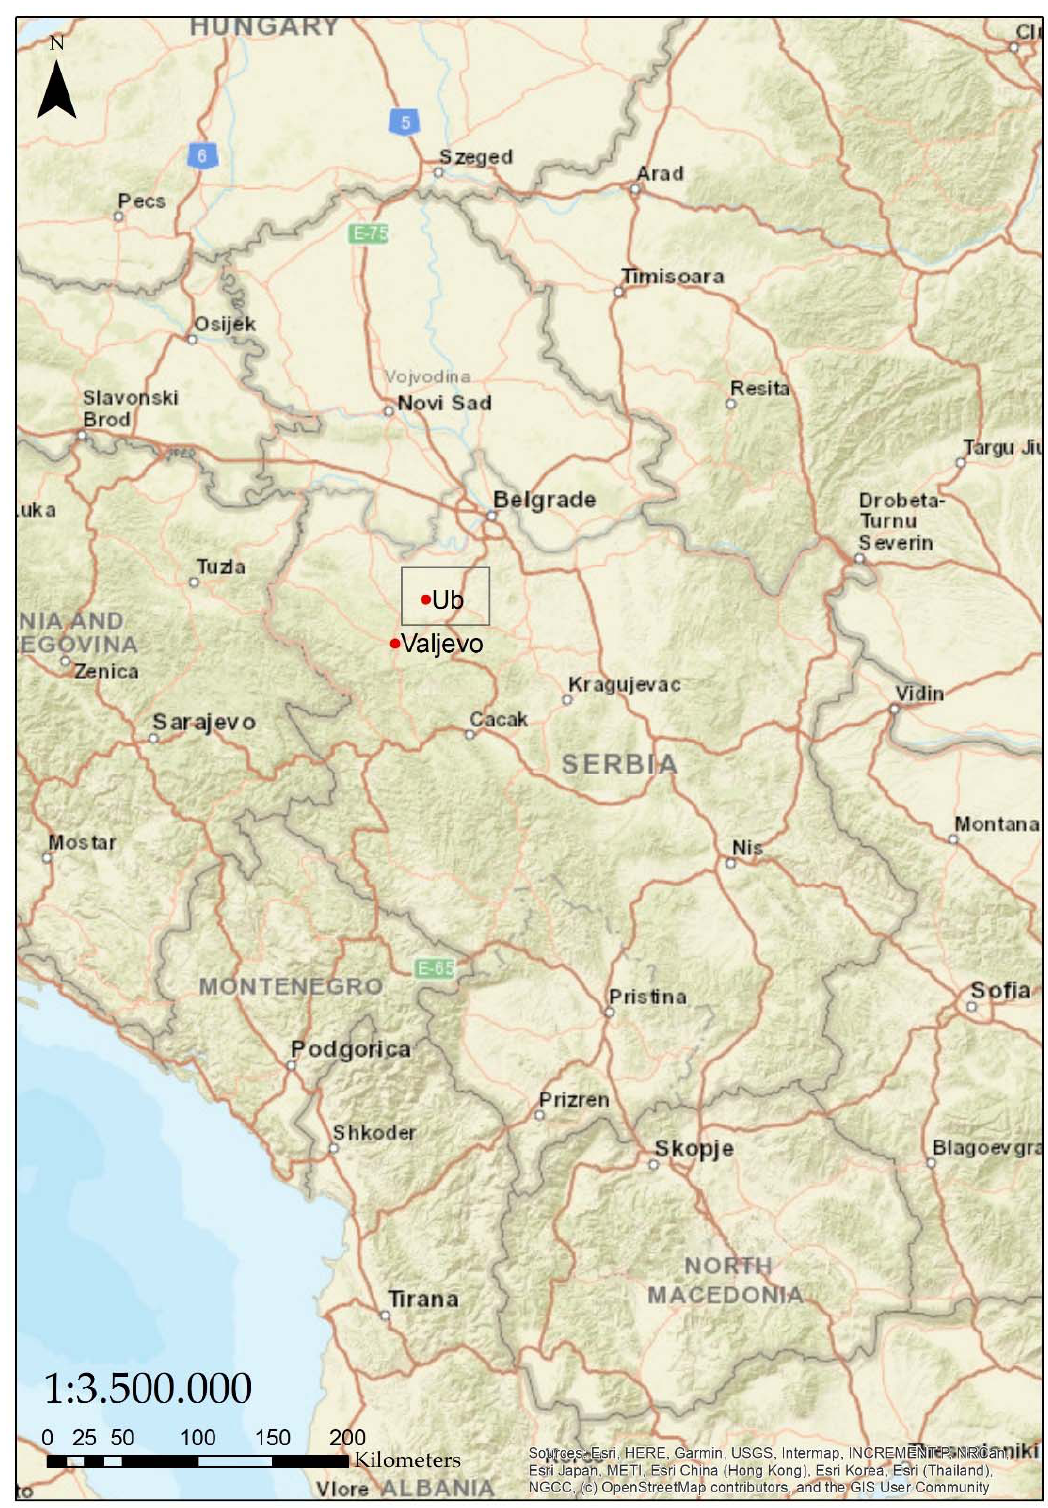
Figure 2. The location of Ub within the Republic of Serbia.